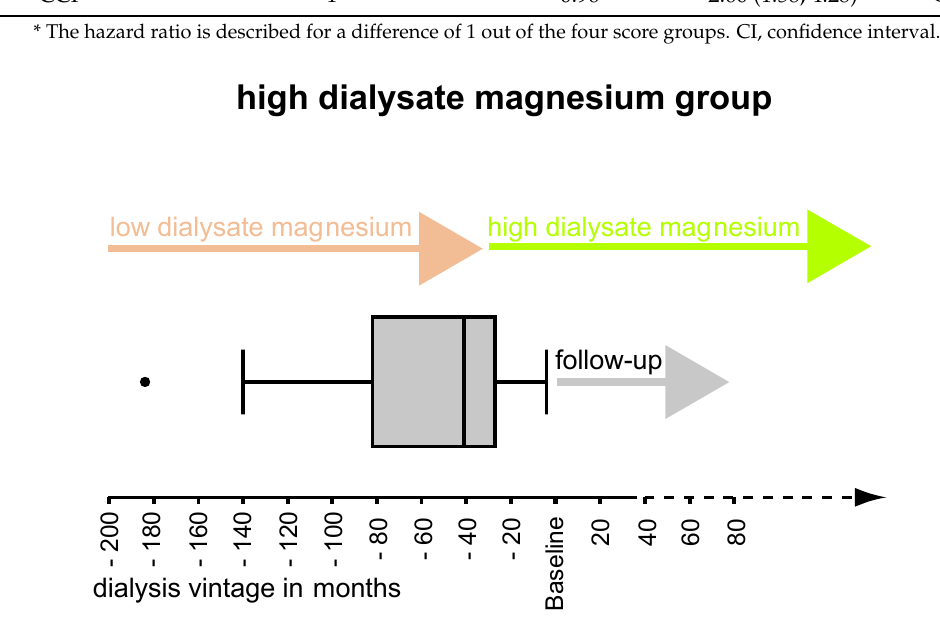
Figure A1. Box plot of the dialysis vintage in the high dialysate magnesium group. Median dialysis vintage of patients in the high dialysate magnesium group was 41.0 (30.0–96.5), minimum was 4 and maximum was 184 months. 17 (68.0%) of the patients were switched 31–33 months before baseline from low (0.50 mmol/L) to high dialysate magnesium (0.75 mmol/L). The dialysate magnesium concentration was not changed during the follow-up period.